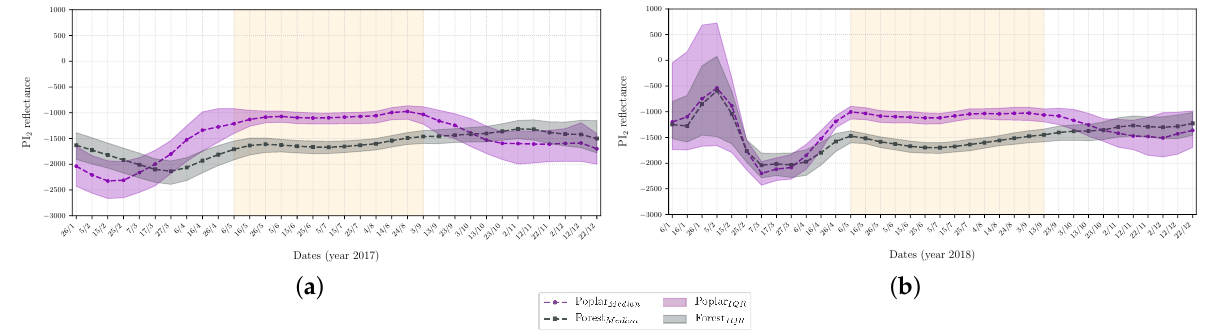
Figure A5. Temporal profile of PI 2 reflectance in poplar plantations versus other deciduous tree species: in ( a ), the profile in 2017; in ( b ), the profile in 2018. Dashed lines refer to the median signal, and the surrounding shaded areas represent the interquartile range, shown in purple for poplar and in grey for other deciduous species. The light yellow box highlights the most discriminating spring–summer period for